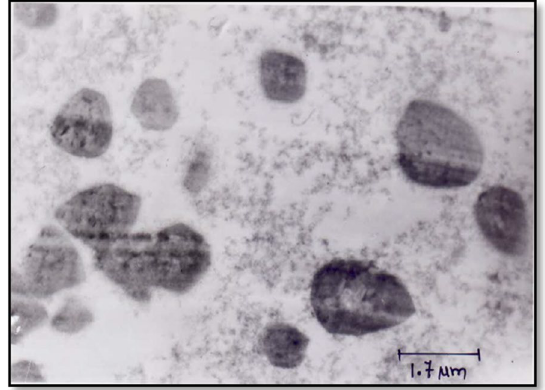
Fig. 3 Transmission electron micrographs depicting tetrahedral and triangular OBs isolated from baculovirus-infected larvae of Spilosoma obliqua